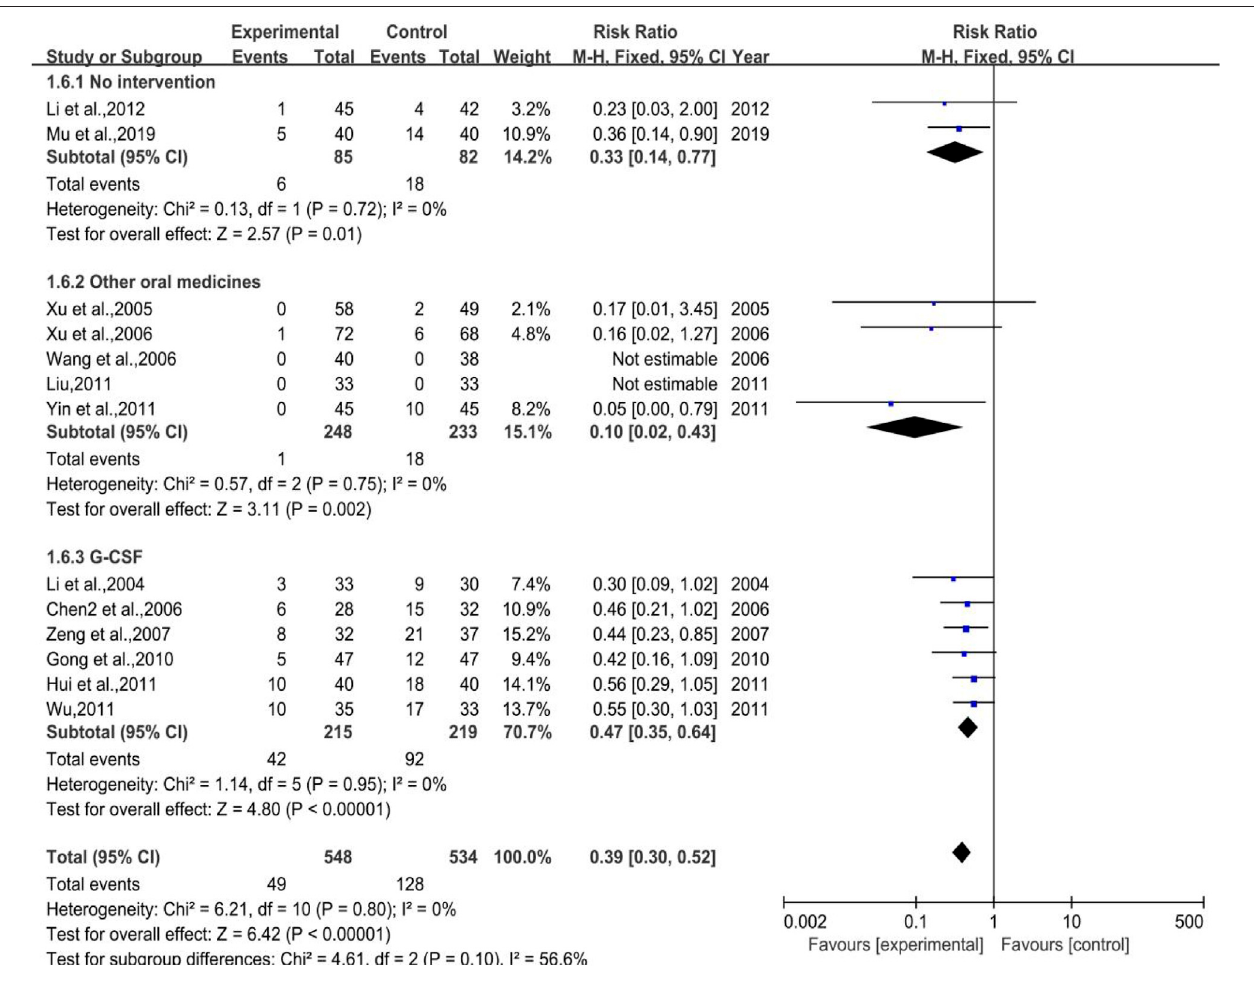
FIGURE 8 | The forest plot of III-IV degree white blood cell suppression rate in preventive medication.